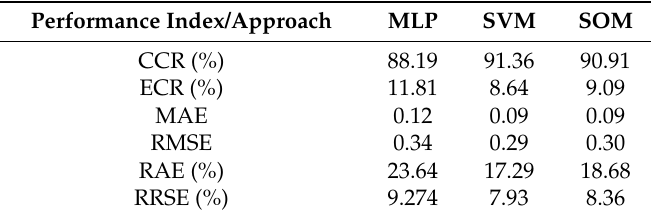
Table 3. Comparative study of MLP, SVM and SOM.